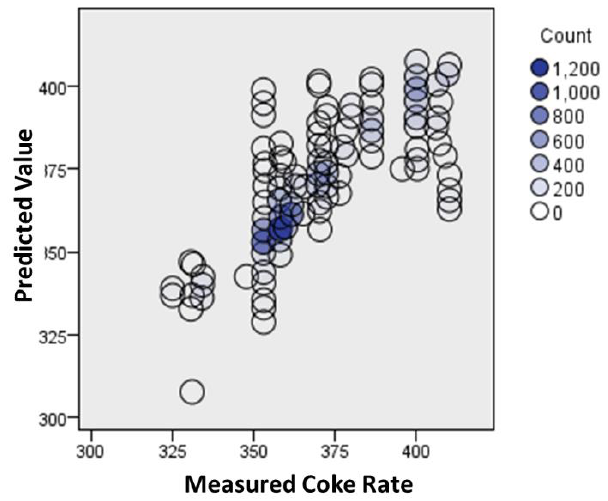
Figure 17. Relationship between the measured and predicted coke rate in the multiple linear regres- sion model.